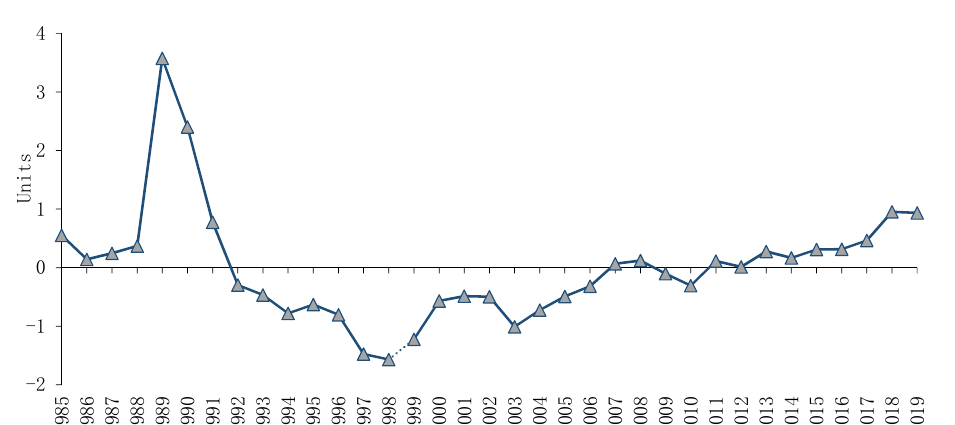
Figure 2. Sustainability index for public health. Source: Computed by authors processing data using Stata 15.0.